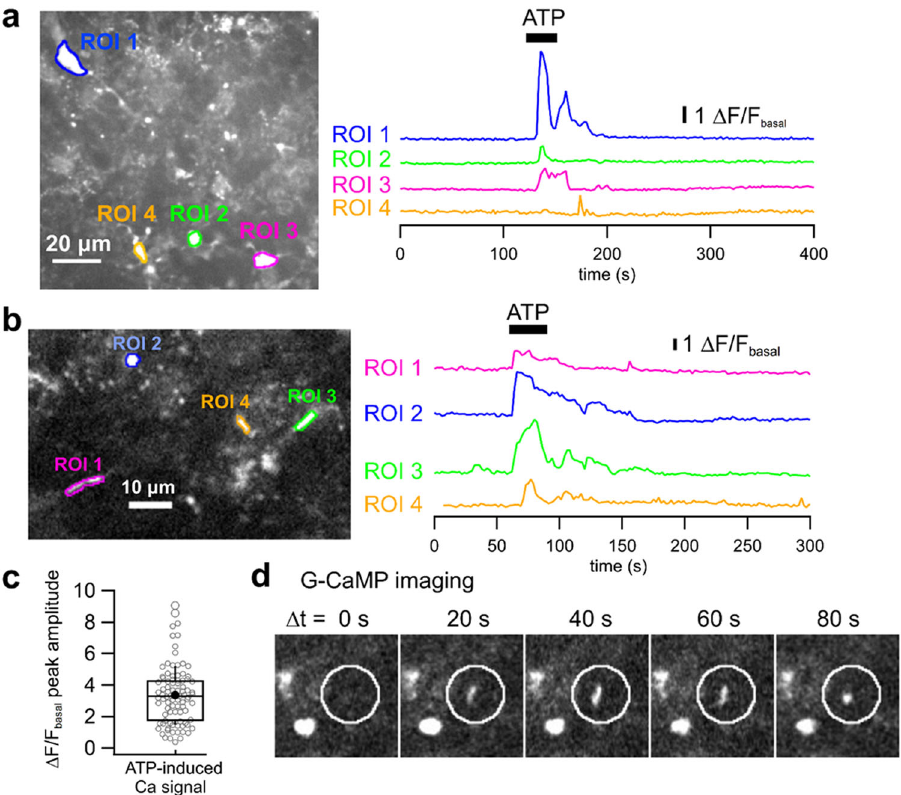
Fig. 7 Application of our microglia-selective gene expression method in expressing the genetically encoded Ca 2 + indicator G-CaMP7.09 and measuring Ca 2 + signals in cerebellar microglia. a , b Left panels show the averaged confocal images of virally expressed G-CaMP signals in the granule cell layer of acute cerebellar slices. Regions of interest (ROIs 1 – 4) were set on larger compartments (possibly microglial somata or their larger processes) in a and on smaller compartments (possibly fi ne microglial processes) of the microglia in b . The right panels show traces of Ca 2 + signal changes estimated from the fl uorescence of the ROIs illustrated in the left panels. Bath application of 100 µ M ATP (indicated in black bars) evoked Ca 2 + transients robustly in both the larger and the smaller compartments of the transduced microglia. c A box and whisker plot showing quanti fi ed Ca 2 + signals induced by bath- applied ATP ( Δ F/F basal , see methods) in the microglial cellular compartments. Open circles indicate individual data points. The horizontal line and the box represent the median value and the interquartile range, respectively. The error bars indicate one standard deviation above and below the mean value ( fi lled circle). d Time-lapse fl uorescent images showing the movement of a microglial process expressing G-CaMP7.09 (indicated by a white circle). Note that the other G-CaMP-positive microglial compartments outside the white circle were